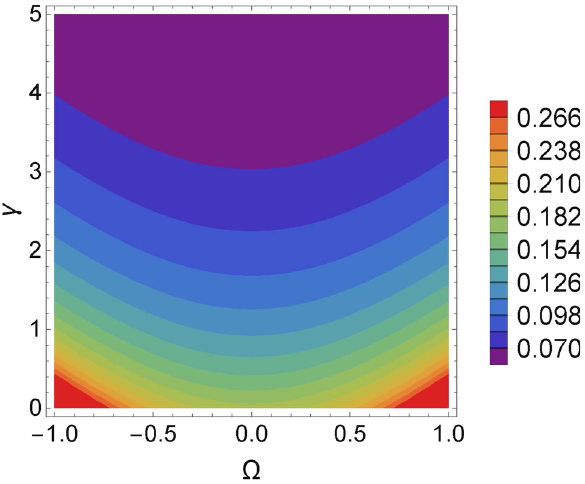
Fig. 9 The entropy S for T = 0 . 5 for the δ – δ (cid:2) comb, (56), in the parameter space Ω − γ . We have chosen for the lattice spacing a = 1